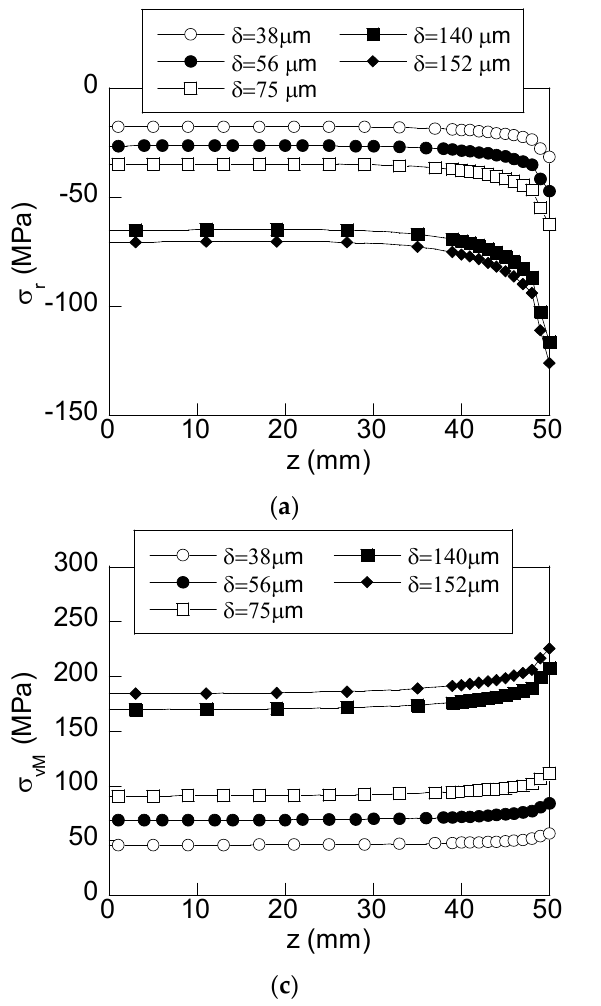
Figure 11. Axial distributions at the interface of: ( a ) radial stress, ( b ) tangential stress, and ( c ) von Mises stress for diverse levels of radial interference ( = 0.125).